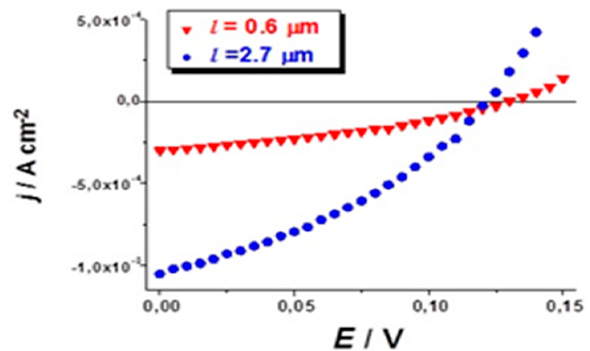
Figure 3. jV characteristic curves of two p ‐ DSCs differing for the thickness ( l ) of the NiO photocathode. Sensitizer is erythrosine B. Electrolyte: 0.1 M I 2 , 1.0 M LiI in acetonitrile. Incident light intensity: 1000 W ∙ m − 2 . The radiation source is sun simulator with Air Mass 1.5. Photoelectrode electroactive area is 4 × 4 mm 2 . Adapted from reference [11].